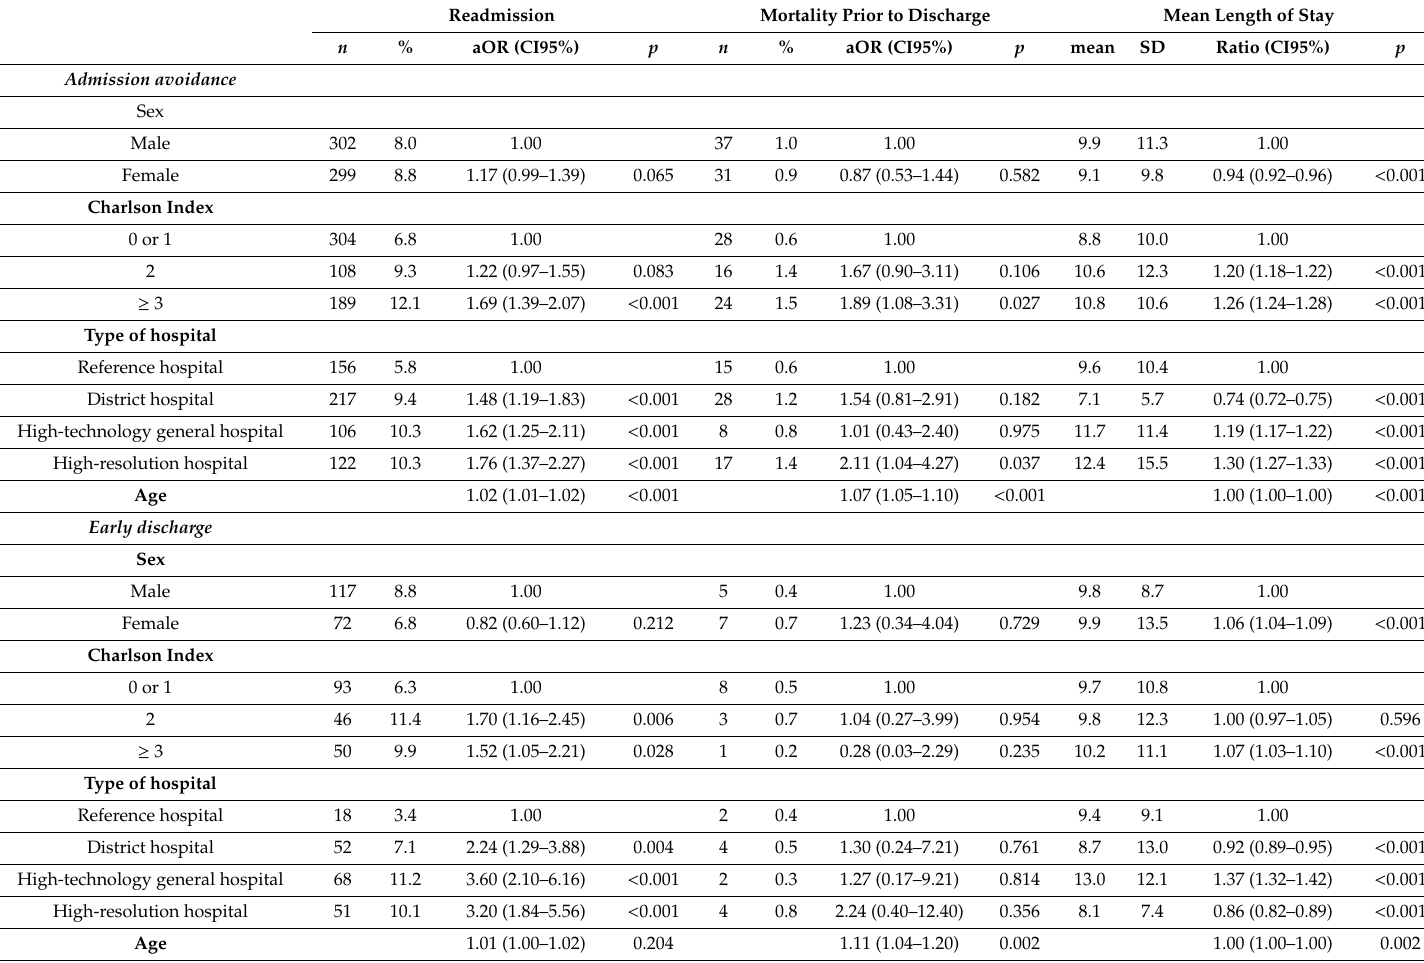
Table 3. Factors related to readmission, mortality, and mean length of stay according to the hospital-at-home